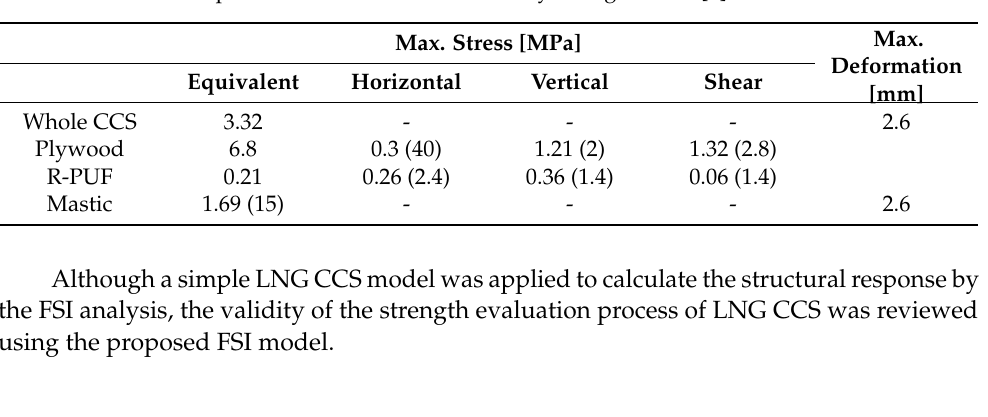
Figure 17. Von-Mises stress distribution and max deformation in CCS: ( a ) at 0.001 s; ( b ) 0.002 s; ( c ) 0.005 s; ( d ) 0.008 s; ( e ) 0.010 s; ( f ) 0.015 s. Table 1. Structural responses review of Mark III CCS by ABS guidance